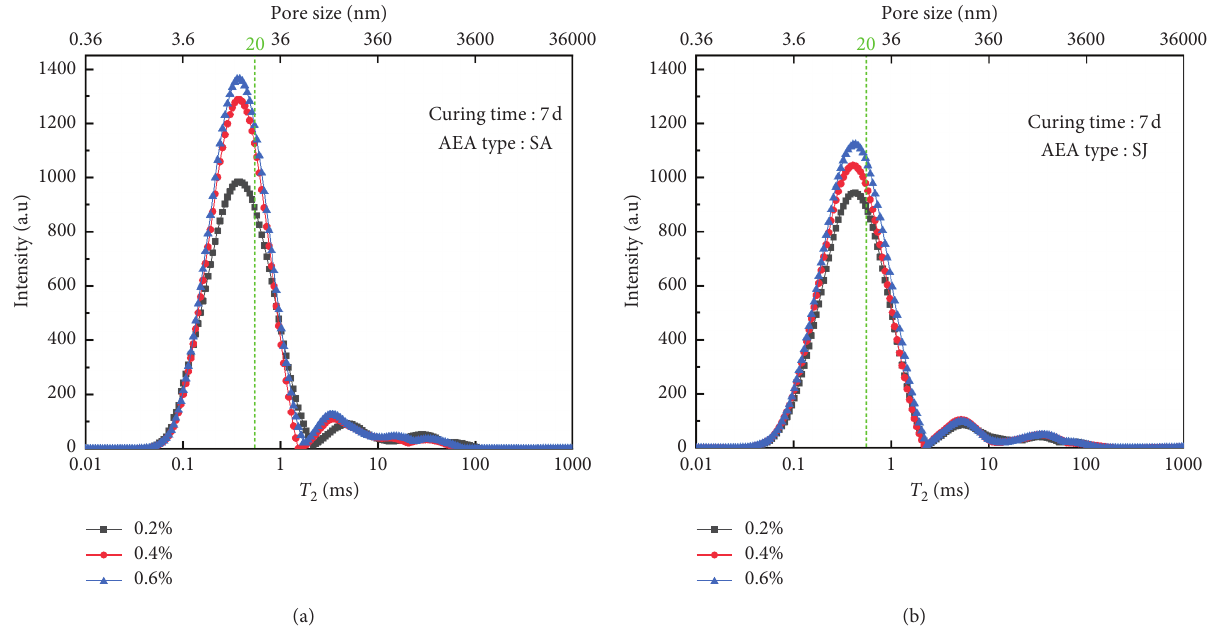
Figure 4: NMR T 2 spectral distribution of AEACPB samples incorporating different concentration of